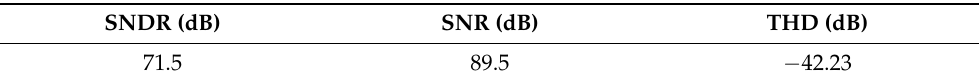
Figure 17. Transmission gate switch circuit. Table 7. The properties of the proposed modulator TG switch.